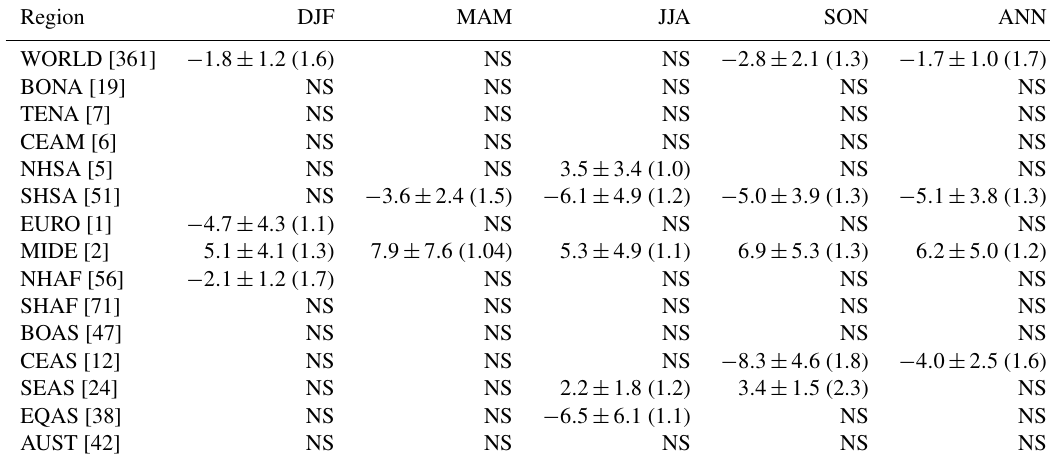
Table 3. Seasonal linear trends of CO emissions from vegetation fires (in %yr − 1 ) over 2002–2017. Uncertainties are given at a 95% confidence level (NS means non-significant). The significance (here defined as the trend normalized by the uncertainty at a 95% confidence level) is given in brackets. The mean annual CO emissions (in TgCOyr − 1 ) are retained in square brackets in the first